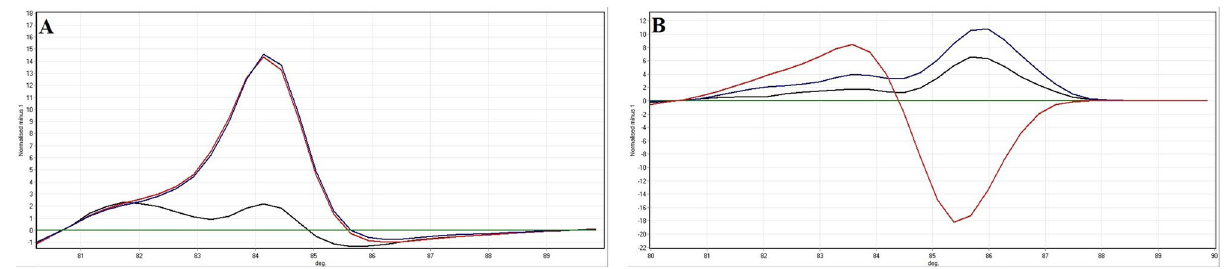
Figure 4. Difference plots of the reference strains of Shigella species analysed by PCR-HRM using ( A ) purA- F-R and ( B ) rrsA-F-R primer pairs. Green curve: S. dysenteriae . Red curve: S. flexneri . Blue curve: S. boydii . Black curve: S. sonnei